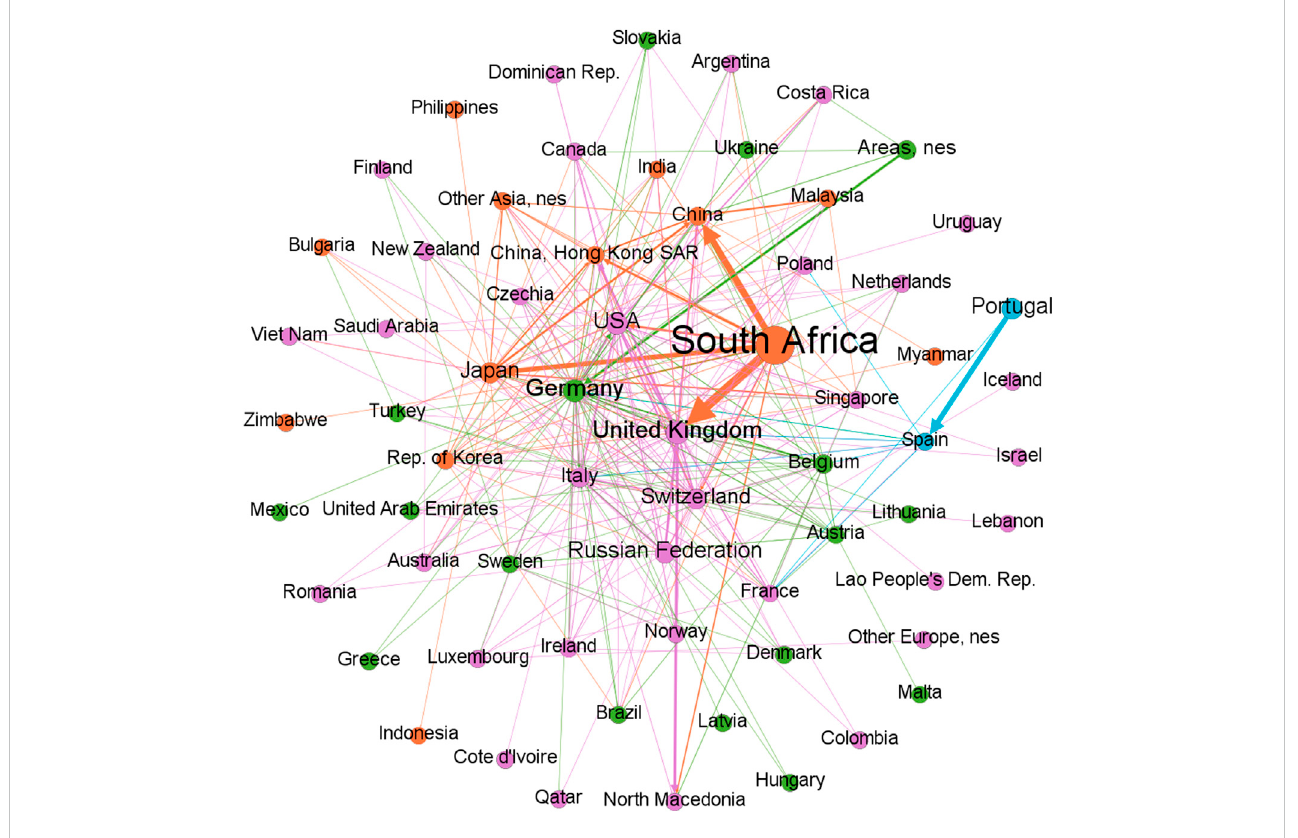
International platinum primary product trade network